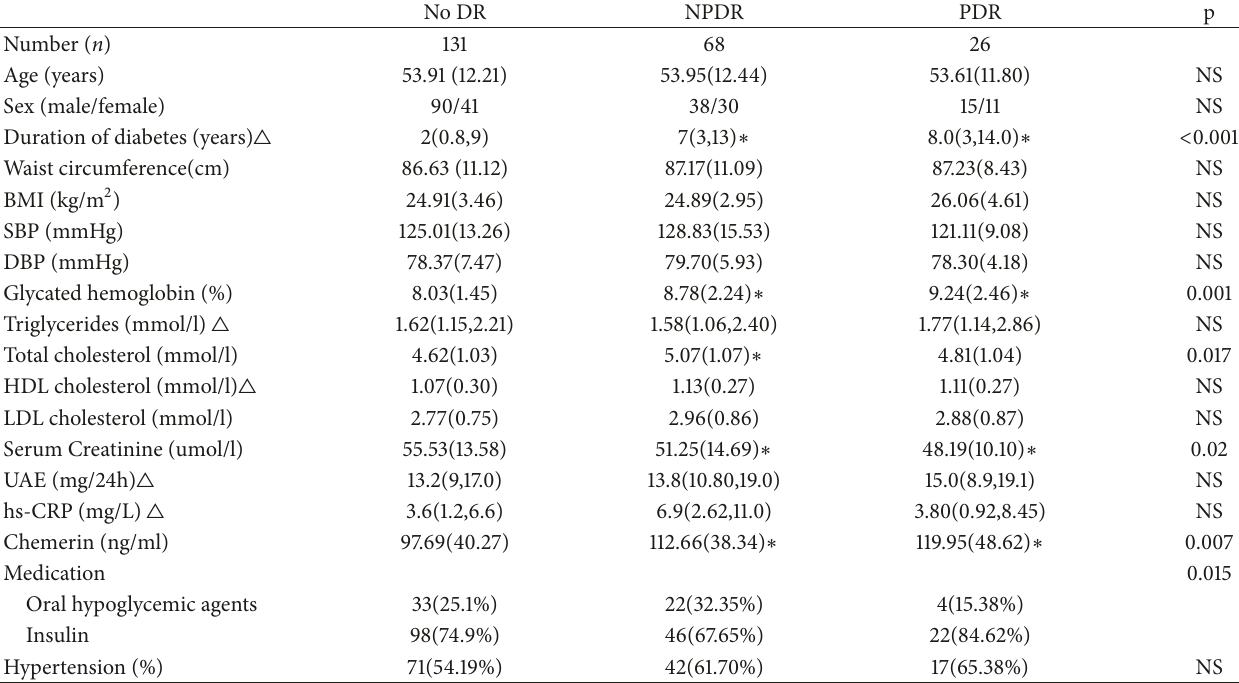
Table 5: Clinical characteristics of type 2 diabetic subjects according to the presence and severity of diabetic